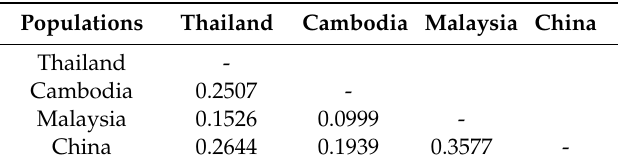
Table 4. The pairwise fixation index (F ST ) among four A. ceylanicum populations based on the partial mitochondrial cox1